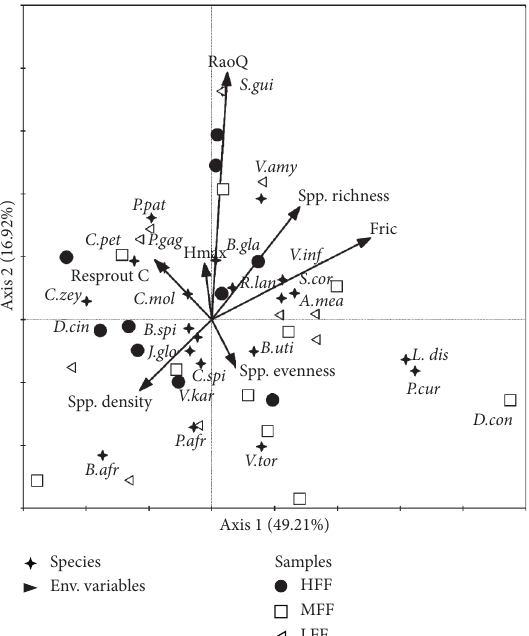
Figure 2: Triplot based on a CCA (first two axes explaining 66.13% of total variation) illustrating the location of the three fire frequency regimes (HFF), medium fire frequency (MFF), and low fire frequency (LFF), environmental variables (Fric � functional richness; RaoQ � Rao’s Quadratic Entropy; Resprout C � resprouting capacity; Spp. � species) and tree species within multivariate space. Key to species: A. mea � Acacia mearnsii ; B.gla � Brachystegia glaucescens ; B.spi � Brachystegia spiciformis ; B.uti � Brachystegia utilis ; B.afr � Burkea africana ; patula ; P.gag � Protea gaguedi ; P.afr � Prunus africana ; R.lan � Rhus lancea ; S.cor � Syzygium cordatum ; S.gui � Syzygium guineense ; V.Amy � Vachellia amythethophylla ; V.kar � Vachellia karroo ; V.tor � Vachellia tortilis ; V.infa � Vangueria infausta